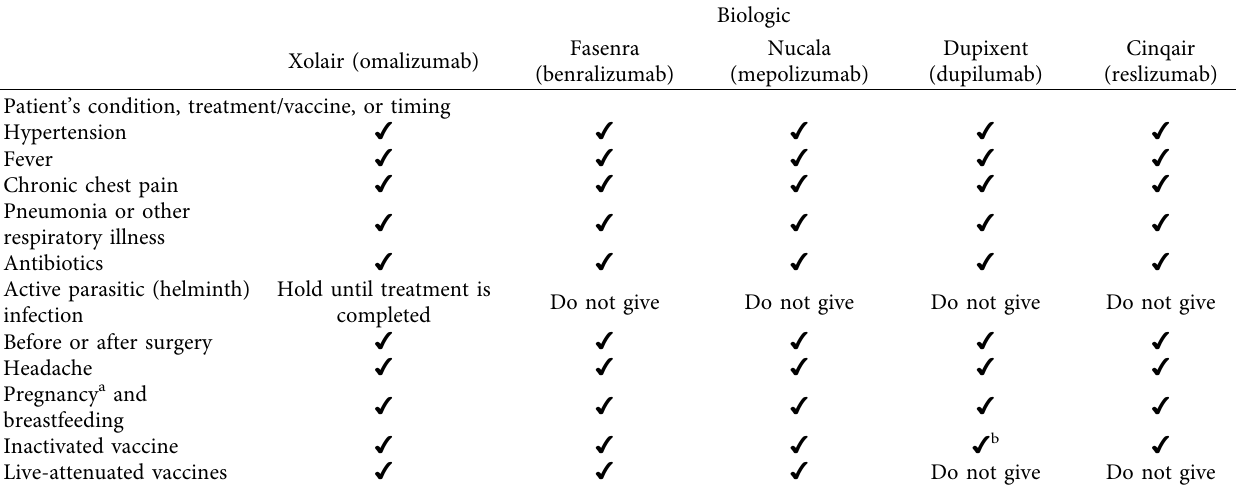
Table 1: When can biologic treatment be administered?.